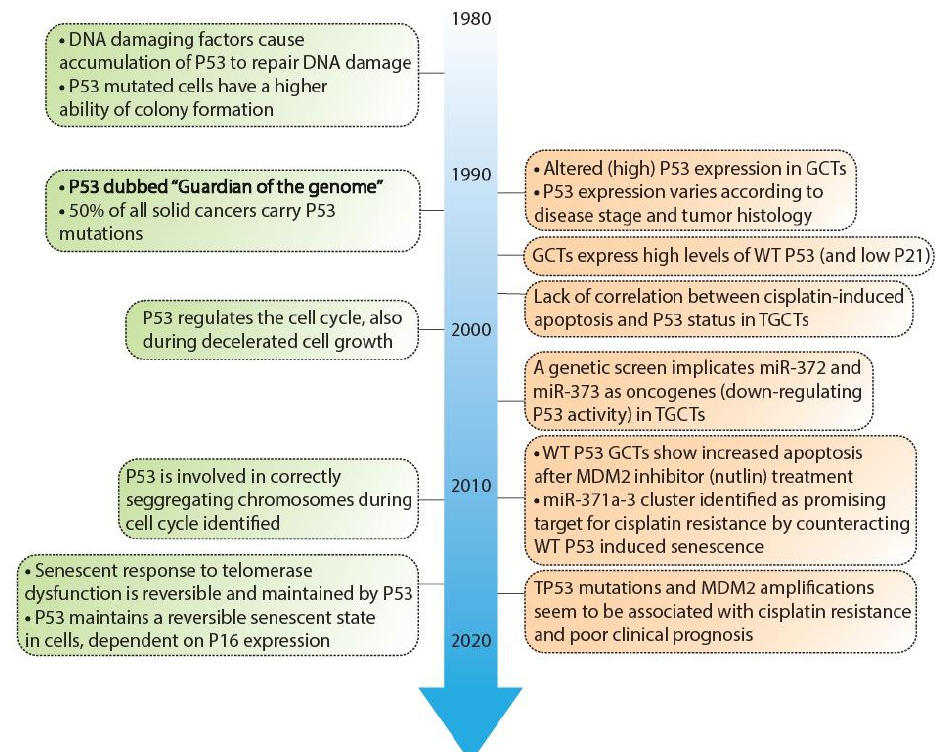
Figure 2. Timeline depicting key discoveries in P53 signaling and germ cell tumors. A timeline of